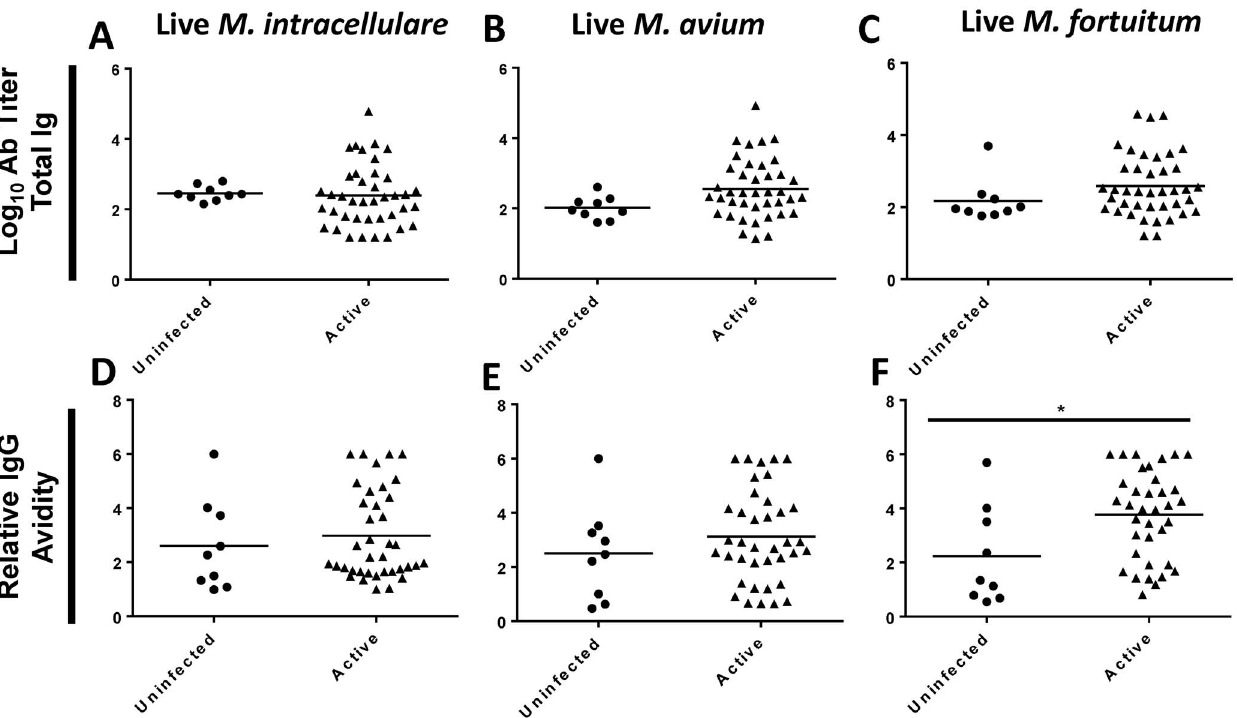
Figure 3. Reactivity of human plasma to surface of environmental mycobacteria. Plasma from PPD-negative volunteers (Uninfected), patients with latent TB infection (Latent), or patients with active TB disease (Active) were assayed by ELISA against the surface of live M. intracellulare ( A,D ) M. avium (B,E ), and M. fortuitum (C,F ). Log 10 total Ig titers and relative IgG avidity are displayed. Two-sided p-values by student’s t-test or Mann-Whitney test: (*) p # 0.05, (**) p # 0.01, (***) p # 0.001.